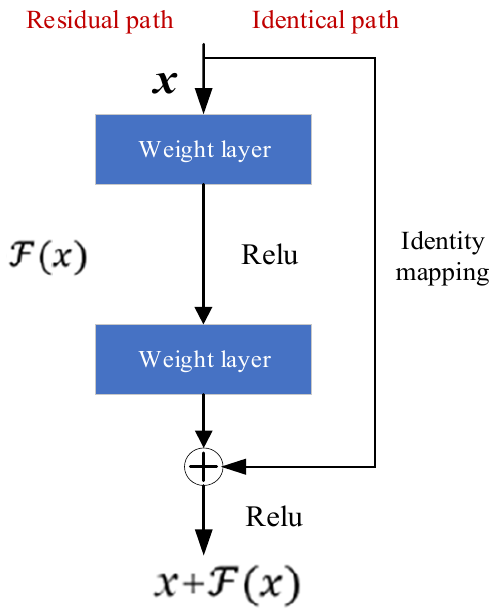
Figure 2. Schematic graph of residual unit.